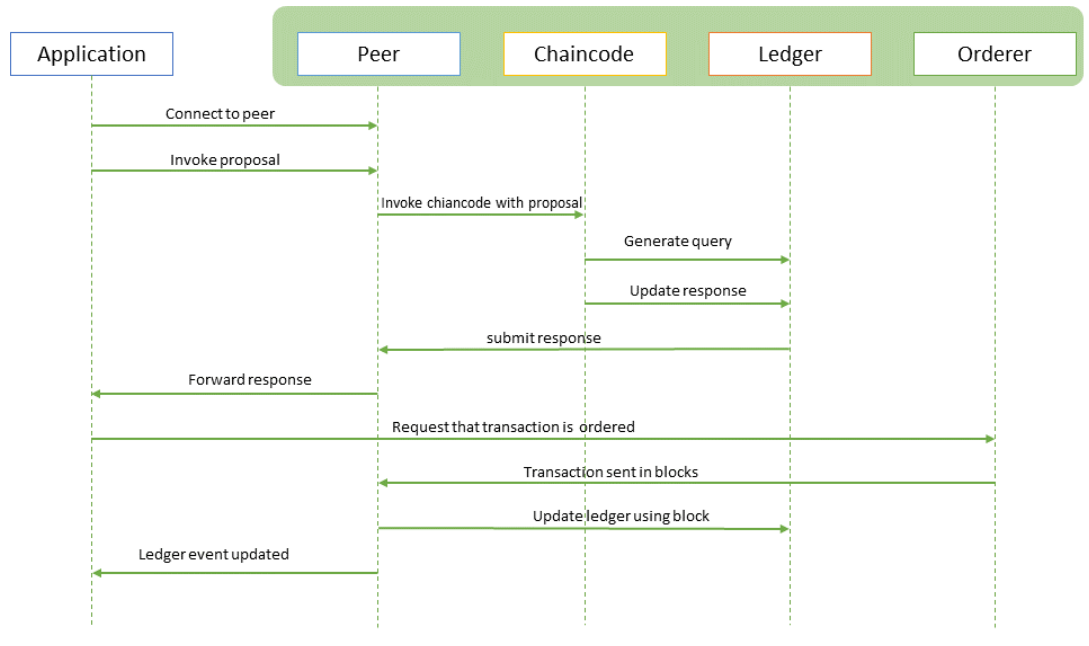
Figure 4. A sequence diagram of transaction processing.